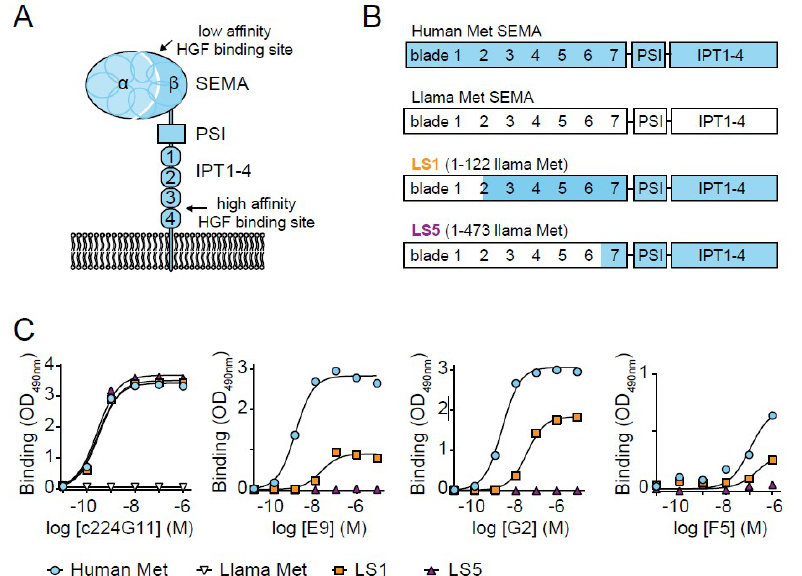
Figure 1. Selected VHHs (variable domains from the heavy chain of llama heavy chain antibodies) recognize SEMA (semaphorin-like) subdomain on human Met ectodomain. ( A ) Met ectodomain consisting of a large SEMA subdomain (a cleaved seven-bladed propeller alpha and beta subunit), a PSI (plexin, semaphorin, integrin-like) subdomain, and four IPT (immune-globulin-like, plexins, transcription factors) subdomains. HGF (hepatocyte growth factor) binds with low affinity to the SEMA subdomain and with high affinity to the IPT subdomains. ( B ) Schematic representation of human (blue) and llama (white) Met and the two chimeric Met variants LS1 and LS5 (llama SEMA) in which either the first 122 or 473 amino acids of the human Met were replaced with those from llama. ( C ) Representative figure of binding of either the conventional control antibody c224G11 or the VHHs E9, G2, or F5 to the four Met variants in ELISA ( n = 2).